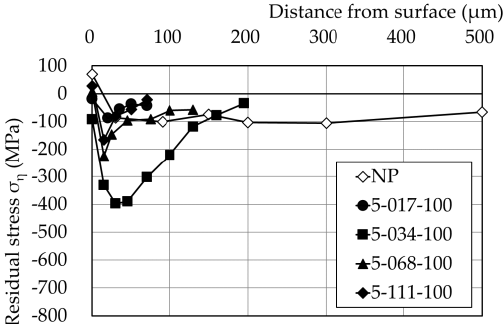
Figure 9. Residual stress depth distribution (5 mJ).